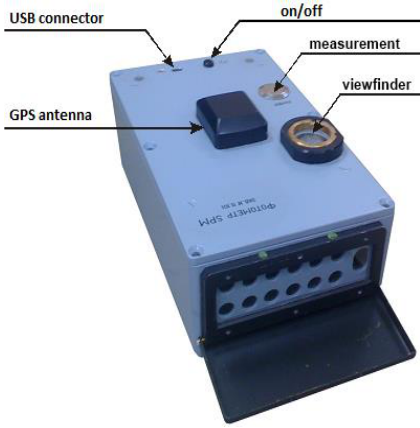
Figure 1. SPM handheld sun photometer.